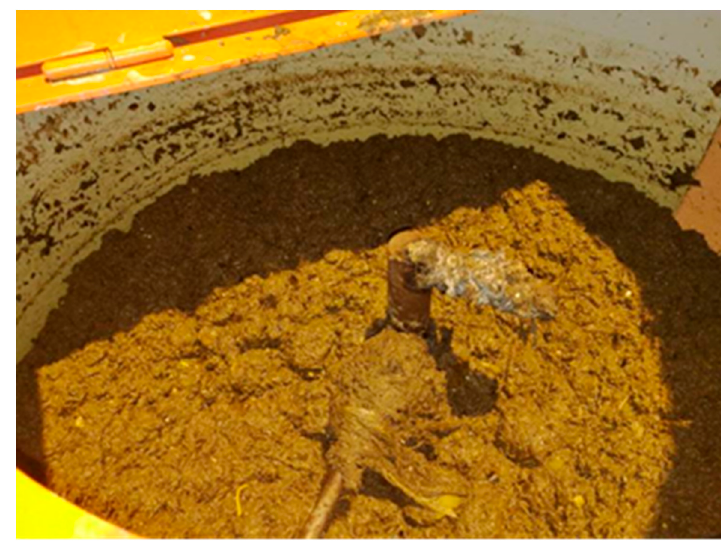
Figure 3. Mushed and mixed OFMSW used as feed for the dry-AD.